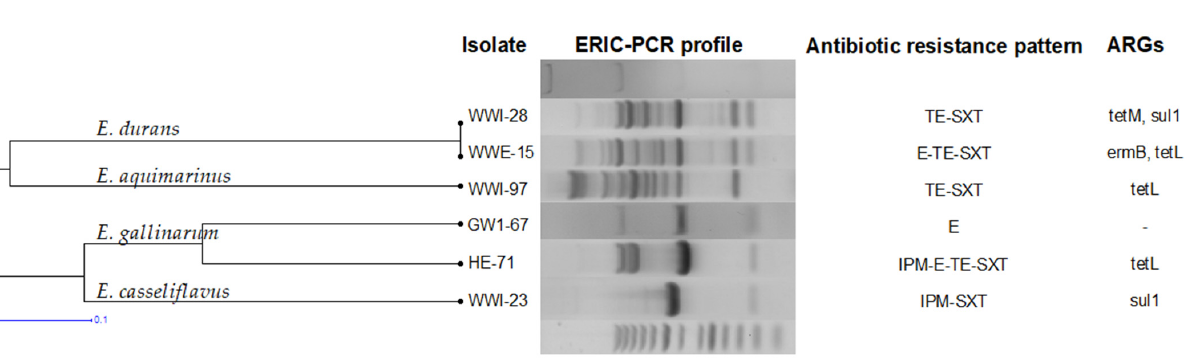
Figure 6. ERIC-PCR dendrogram and antibiotic resistance profiles of other Enterococcus spp. The isolates were labelled by sources: GW = groundwater; HE = hospital effluent; WWI = wastewater influent; WWE = wastewater effluent.